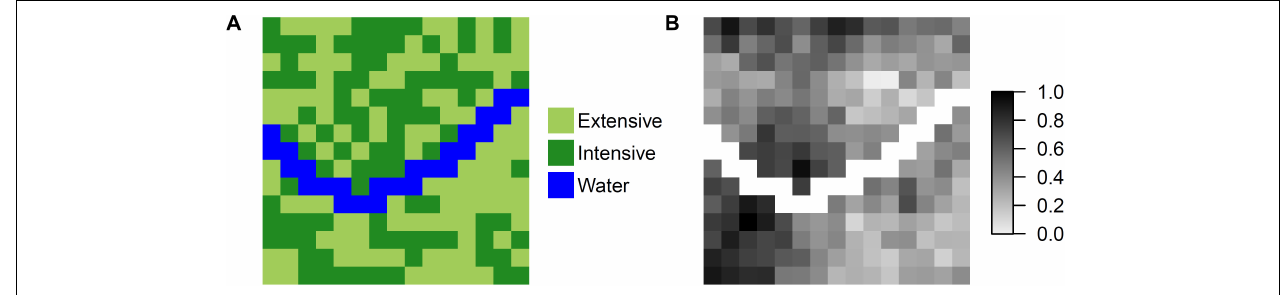
FIGURE 2 | Virtual land use (A) and soil fertility (B)